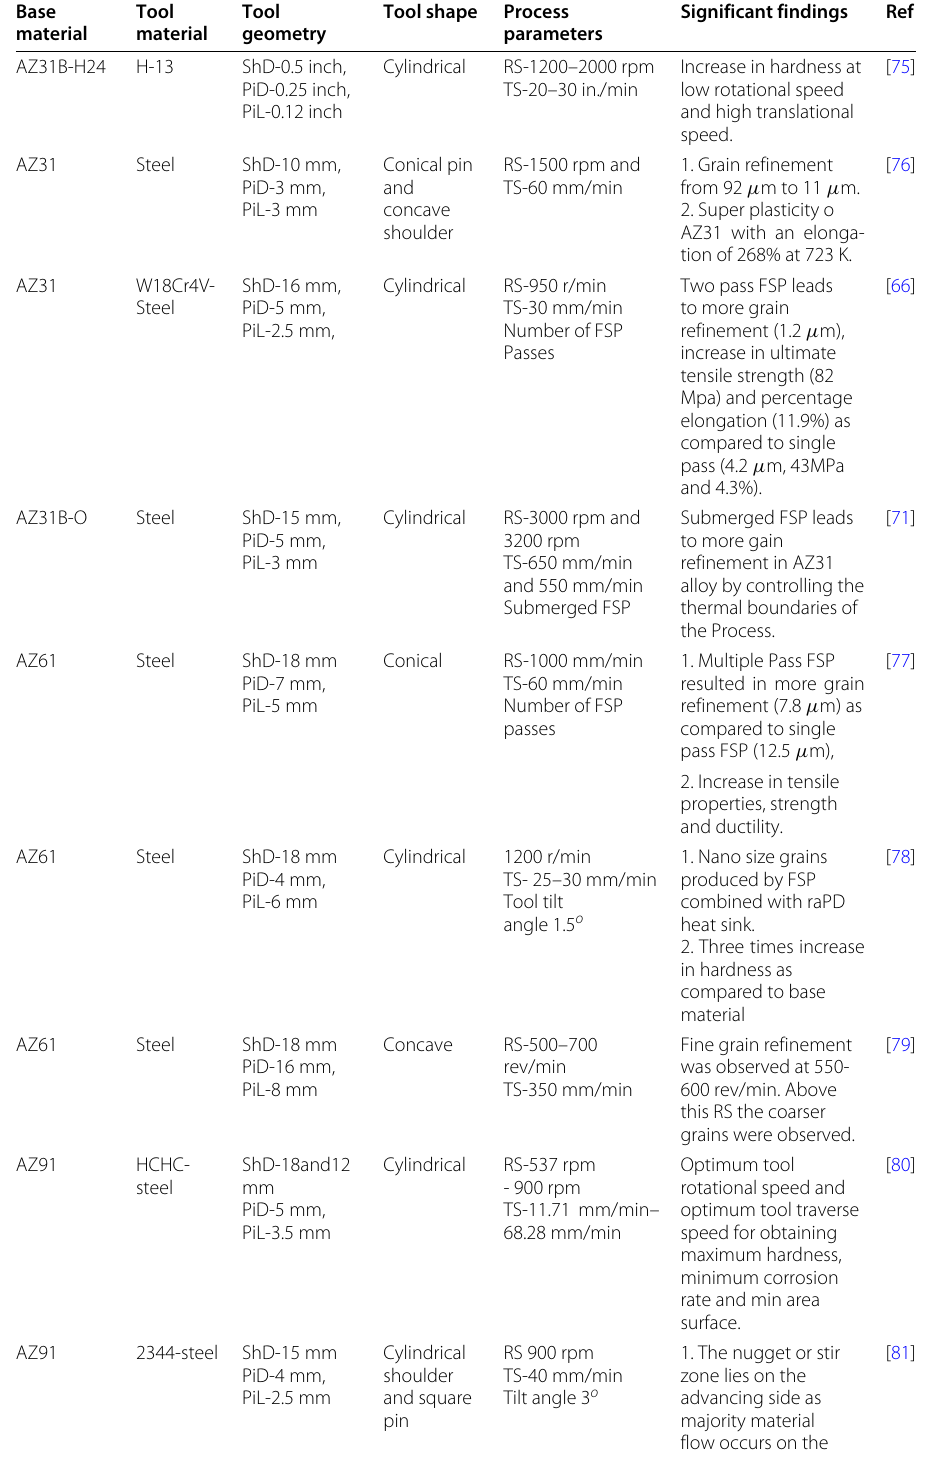
Table 2 Brief summary of surface modification of Mg-AZ system alloys by FSP available in the